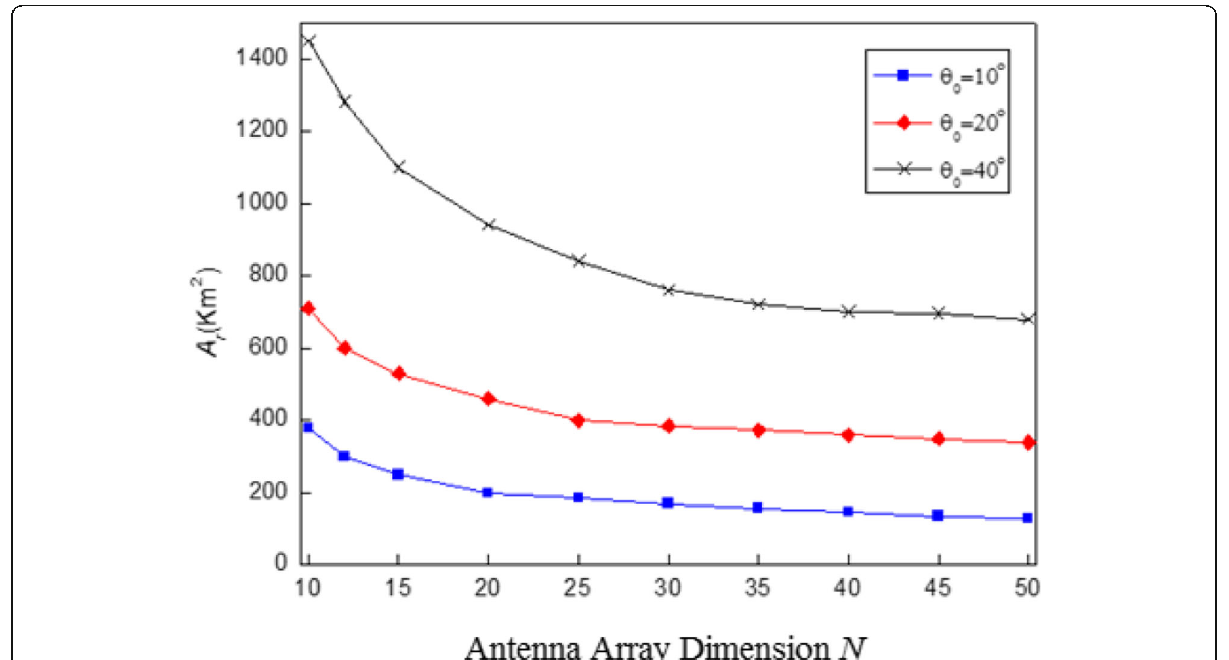
Fig. 6 Relationship between antenna dimensions and annular cell area under different antenna elevation angles θ